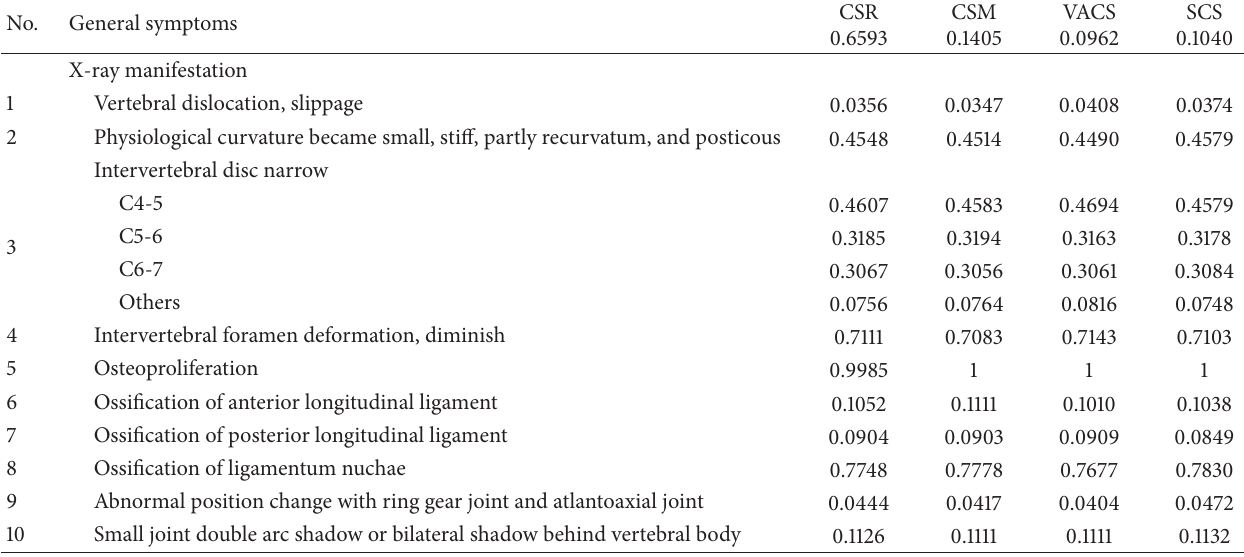
Table 1: CS Symptoms versus